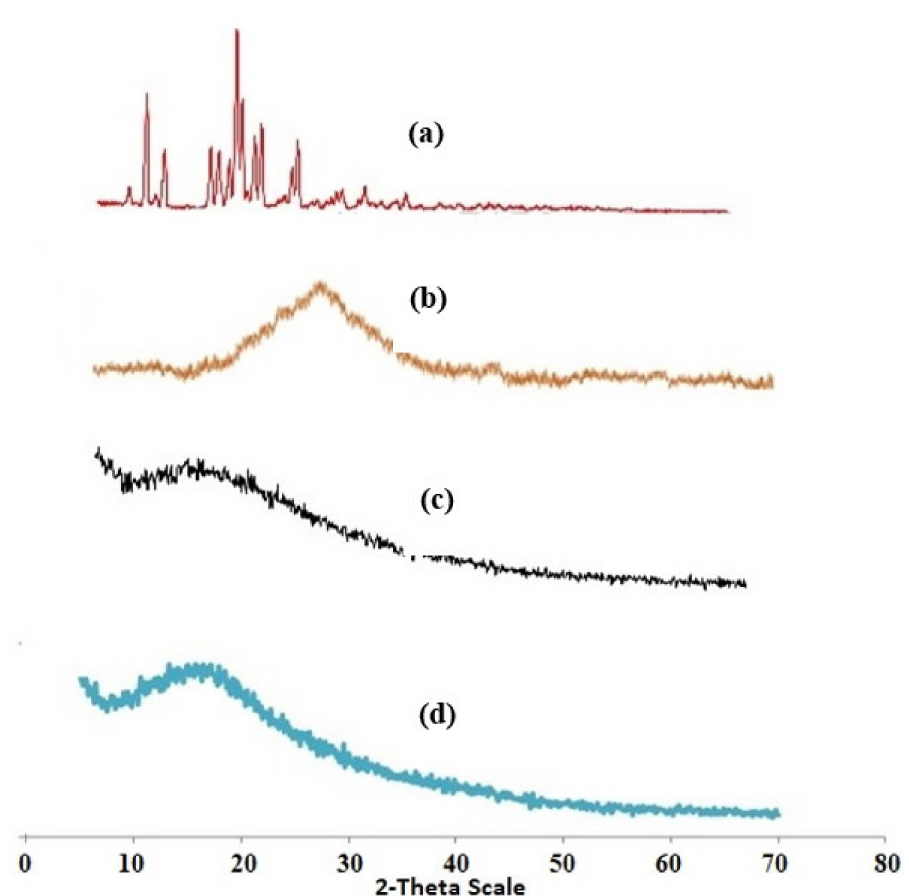
Figure 5. X-ray diffraction patterns of ( a ) pure drug (SIM), ( b ) polymer (chitosan), ( c ) unloaded nanomatrices, and ( d ) SIM-loaded